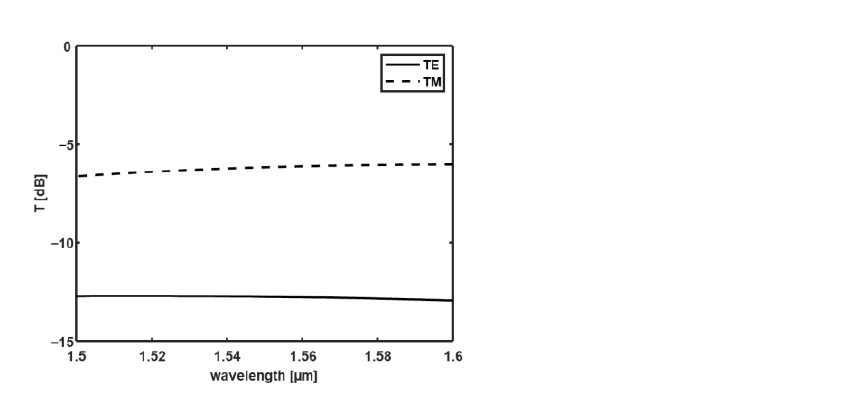
Figure 15. Transmittance in dB, which is calculated at the receiver waveguide as a function of wavelength for the TE (solid curve) and the TM (dashed curves) polarizations. The link distance is d link = 100 µ m, and a multilayer structure with PMMA as cladding polymer and cladding thickness d = 3 µ m is